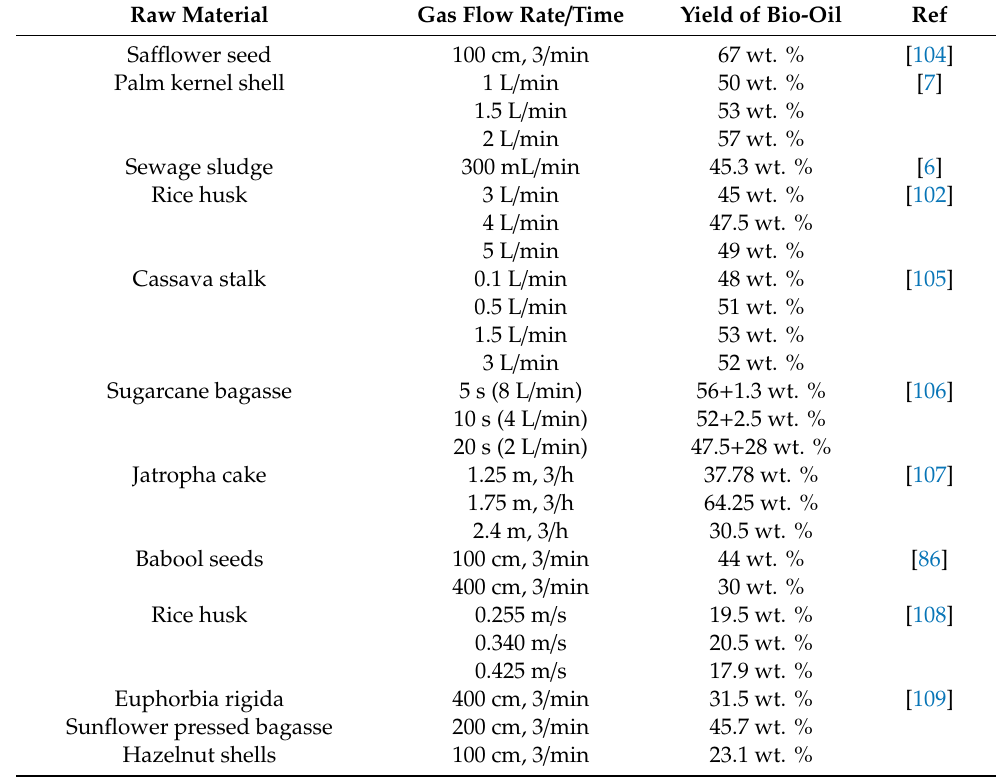
Table 3. Suitable residence time for di ff erent